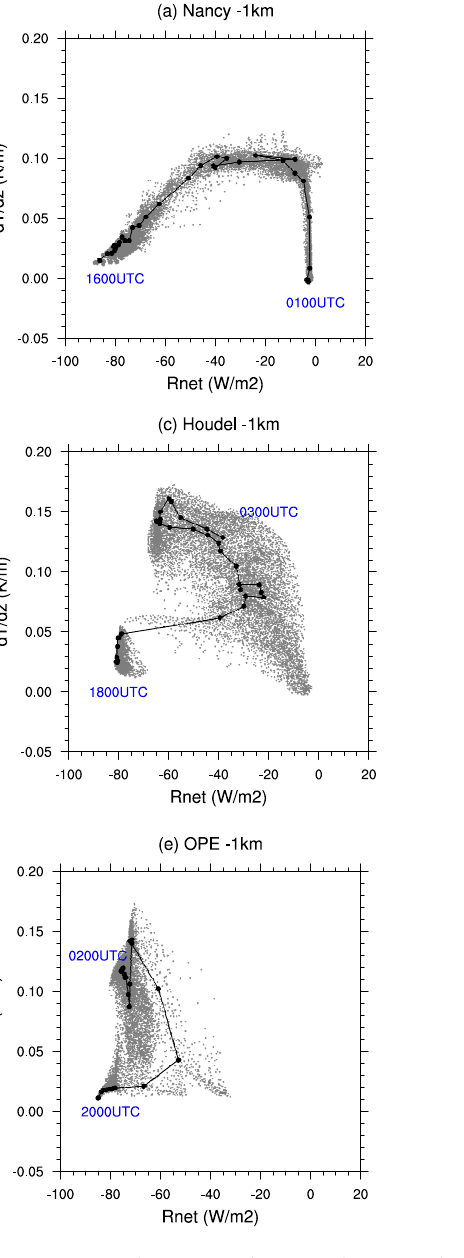
Table 1. Summary of model configuration.